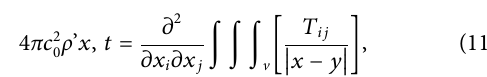
FIGURE 4 | Multi-sensing platforms and computational setup of this study. (A) Multi-sensing platforms to examine displacement and acoustic characteristics of vascularwall vibration and airbornesoundoftheblood fl owmotion. (B) Relative anatomical structures oftheair-conduction transmissionroute ofPTcausedbysigmoid sinus wall dehiscence. (C) Finite element models of the fl ow acoustic fi elds. (D) The fi nite element model, representative radiologic imaging, and representative intraoperative photograph of the temporalis fascia – auricular cartilage (TF-AC) surgical repair method. (E) The fi nite element model, representative radiologic imaging,and representative intraoperative photograph ofthe solidi fi edgelatinsponge-brick (SGS-B) and solidi fi ed gelatinsponge-pieces(SGS-P) method. (F) The fi nite element model, representative radiologic imaging, and representative intraoperative photograph of the solidi fi ed gelatin sponge-bone wax (SGS-BW) surgical repair